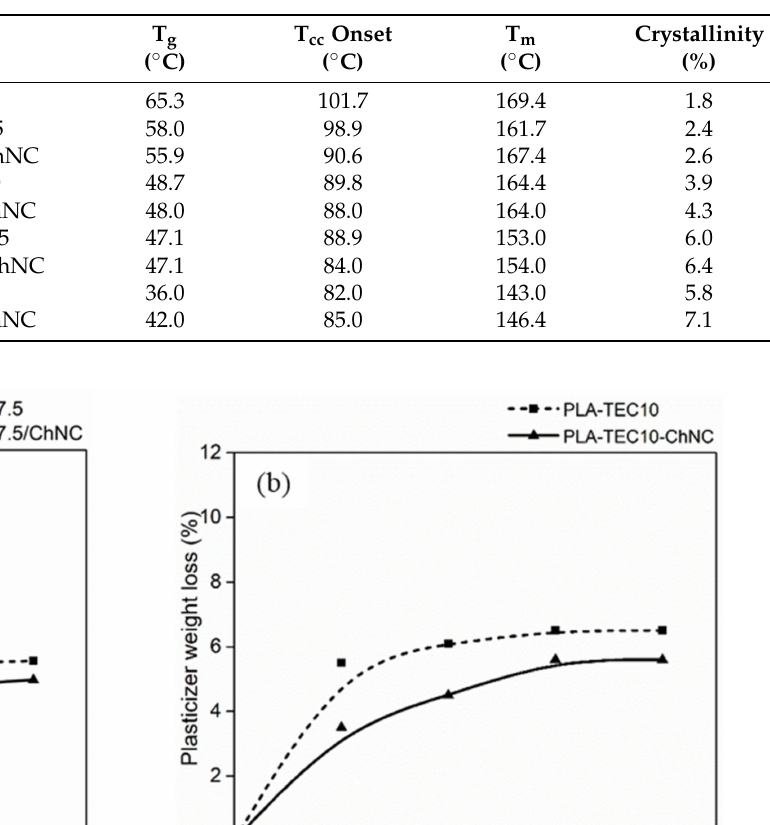
Table 2. Thermal properties of the polymer and its nanocomposites.